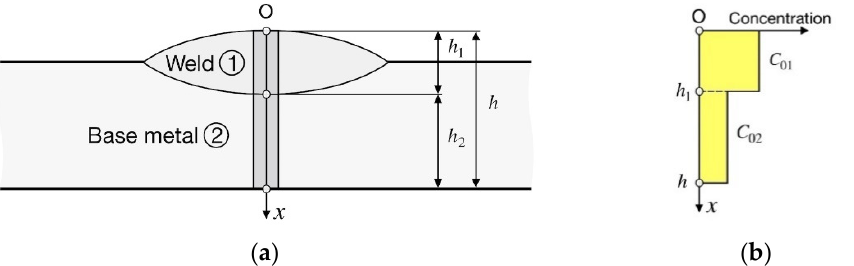
Figure 1. Schematic of a bead-on-plate weld: ( a ) coordinate system; ( b ) initial distribution of hydrogen concentration.